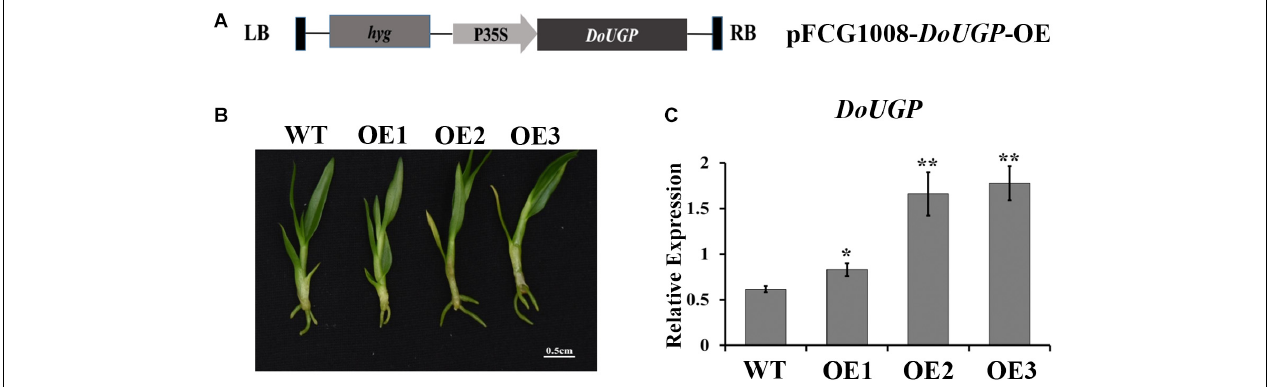
FIGURE 1 | Transformation and verification of DoUGP over-expression plants. (A) Construction of recombinant expression vector pFGC1008– DoUGP –OE. (B) Morphology of wild-type and three independent transgenic DoUGP overexpression lines (OE1–OE3). (C) DoUGP mRNA expression levels in wild-type and transgenic lines. Results are presented as mean ± standard error calculated from three biological replicates. Asterisks indicate the statistically significant differences (Student’s t -test, p <